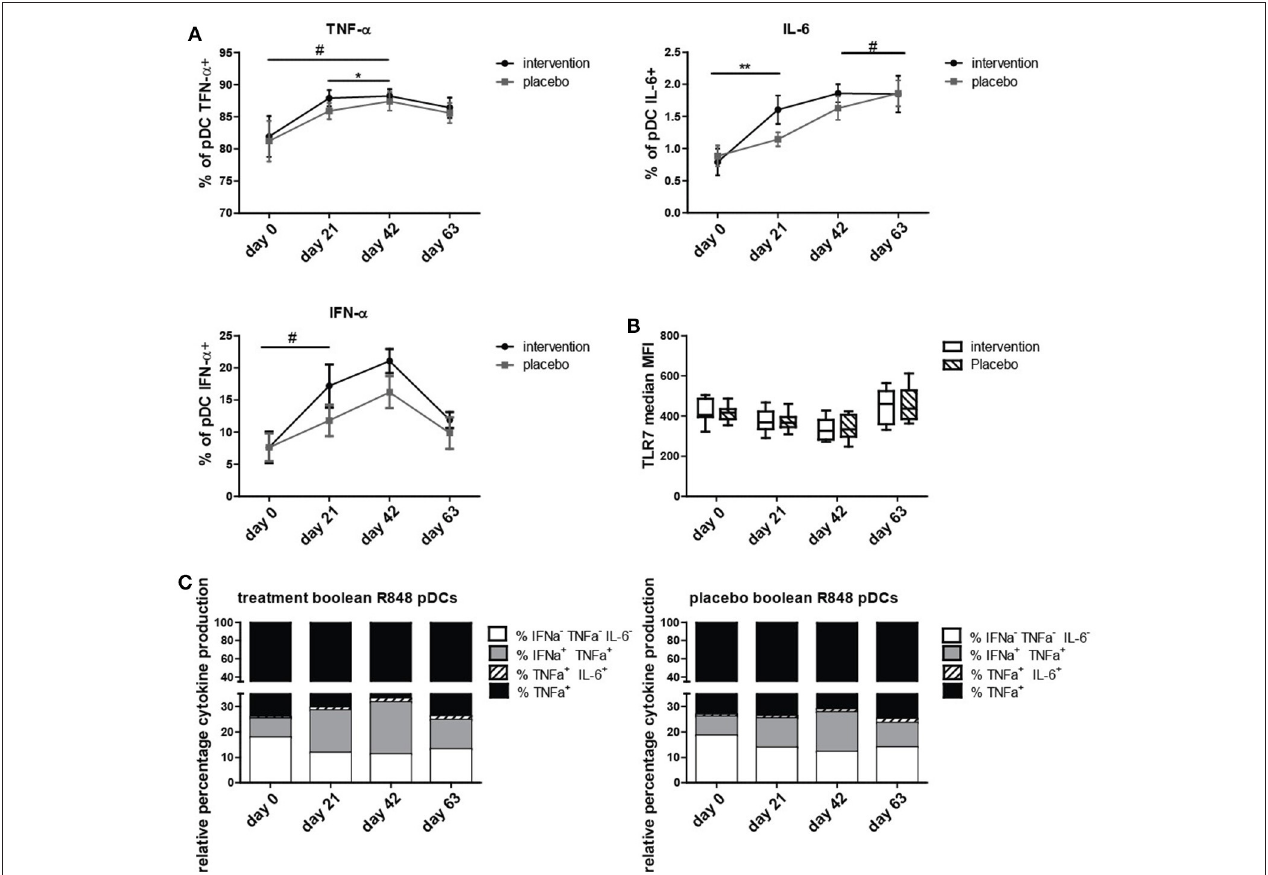
FIGURE 2 | Intracellular cytokine production in pDCs upon R848 stimulation. (A) TNF- α , IL-6, and IFN- α positive pDCs (% positive for cytokine of all pDCs) at study days 0, 21, 42, and 63, shown as mean + / − SEM. (B) TLR7 expression on pDCs at study days 0, 21, 42, and 63. (C) Boolean gating of produced cytokine combinations only by pDCs over time. Statistical analysis was done on ranks based on logit transformed data using repeated measures MANOVA. Outliers ( > 2SD) were removed. * p < 0.05; ** p < 0.01; # is given for trends, all values indicate a difference between Intervention and placebo group over time. # for IFN- α + pDCs is obtained by analyzing days 0 and 21